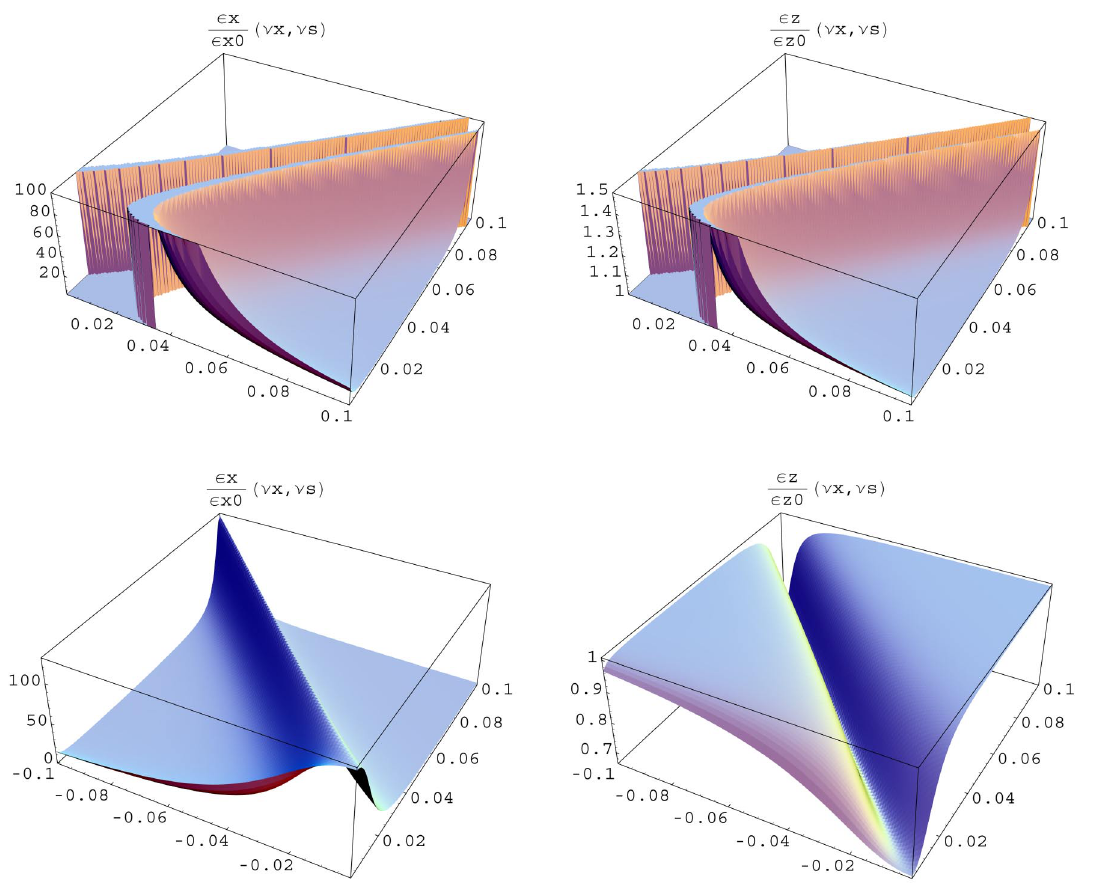
FIG. 6. (Color) 3D plots of projected emittances near the sum and difference resonances due to a crab cavity. The four plots have the same meanings as in Fig. 3. The parameters are the same as those in Figs.